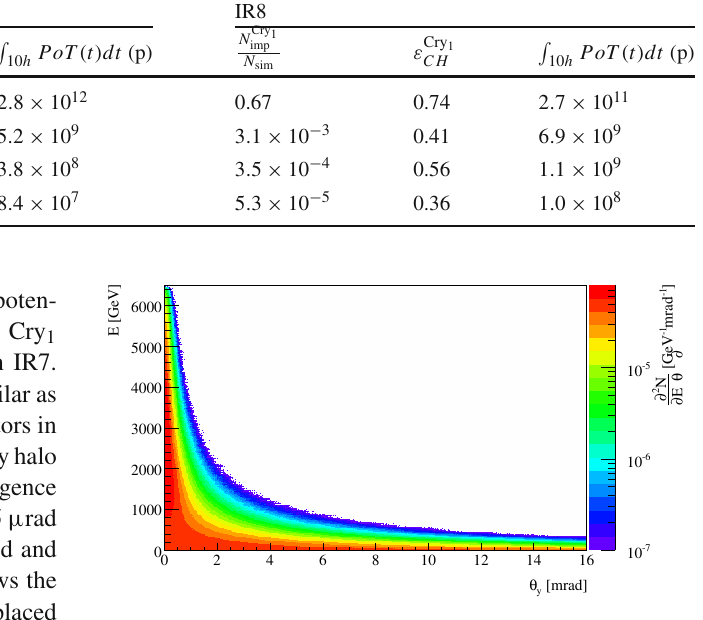
Fig. 10 Distribution of (cid:2) c per 6.5 TeV/c protons on target, obtained using Pythia8.240